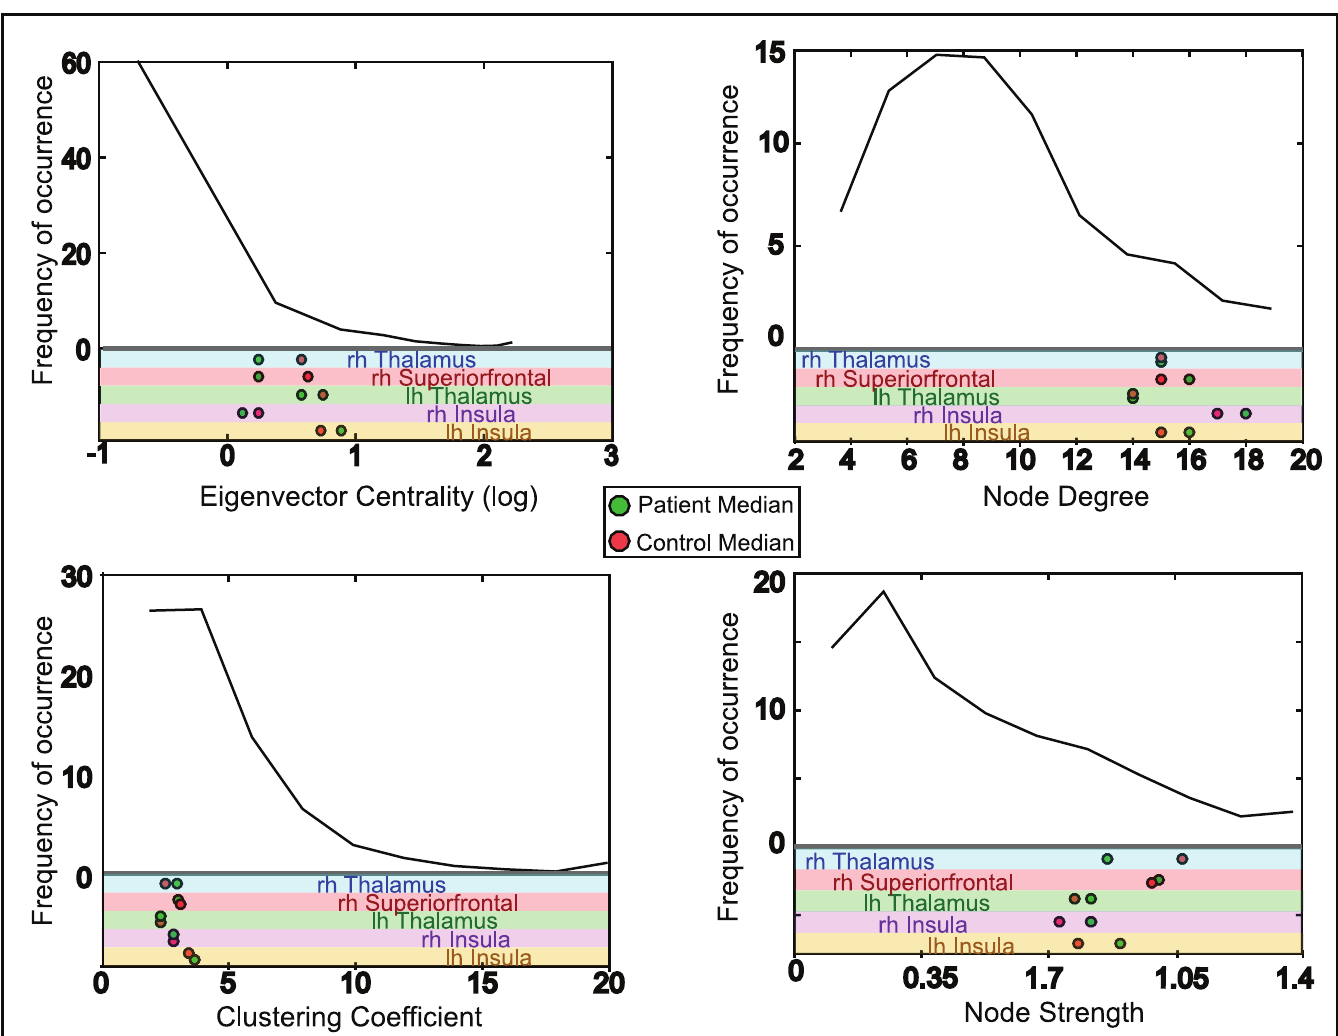
Fig 3. Commonly escaping nodes shared between patients and controls are network hubs. Five of the most commonly escaping nodes in patients and controls occurred in both groups, and different node measures are compared for these nodes here. For each network measure in the figure the distribution for all nodes in all subjects is shown in the top section of the plots. The dots in the lower section reveal where in this distribution the shared nodes occur for the given measure. These locations are shown separately for the ROI in patients and controls (coloured green and red respectively) displaying the median value for the groups. The high node strength, degree and eigenvector centrality values for the shared nodes with a low clustering coefficient support the idea that these regions may be network